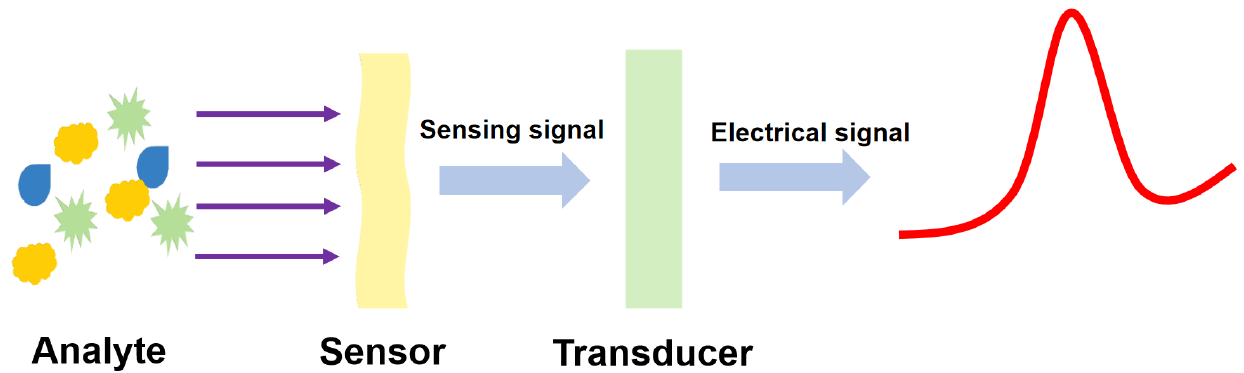
Figure 1. The structure and basic principle of electrochemical sensor.